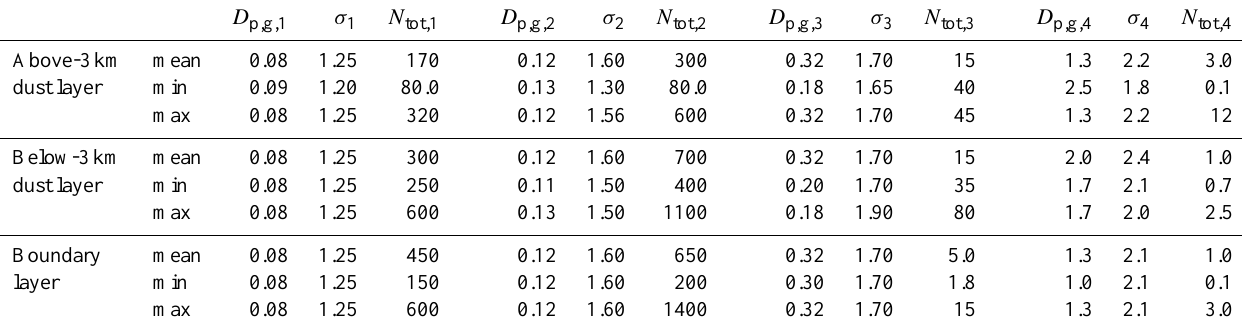
Table 3. Parameters (geometric median diameter D p,g, i in µm, geometric standard deviation σ i and integrated number concentration N tot ,i in no.cm − 3 ) of the four log-normal modes i used to parameterize the number size distributions obtained at the different altitudes. The mean, minimum and maximum of all parameters are